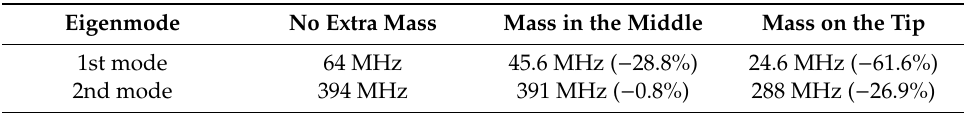
Figure 12. Lorentzian fit of amplitude vs. frequency for the resonance frequency of a MWCNTs with 𝐷 = 102 nm, 𝐿 = 12 µm, 𝐸 (cid:2869) = 82.1 ±16.4 and 𝜈 (cid:2869) = 651.1 kHz, where Q = (cid:2973) (cid:3117) (cid:2940)(cid:2973) = 85. Applied voltage of 10 V. 4. Discussion 4.1. Considerations Regarding Elastic Bending Deformations In many of the aforementioned works, the nanotubes were synthesized by different methods or had considerably smaller diameters than those used in our work. The MWCNTs analyzed here exhibited diameters between 80 and 130 nm, which may be a reason for the low modulus observed,